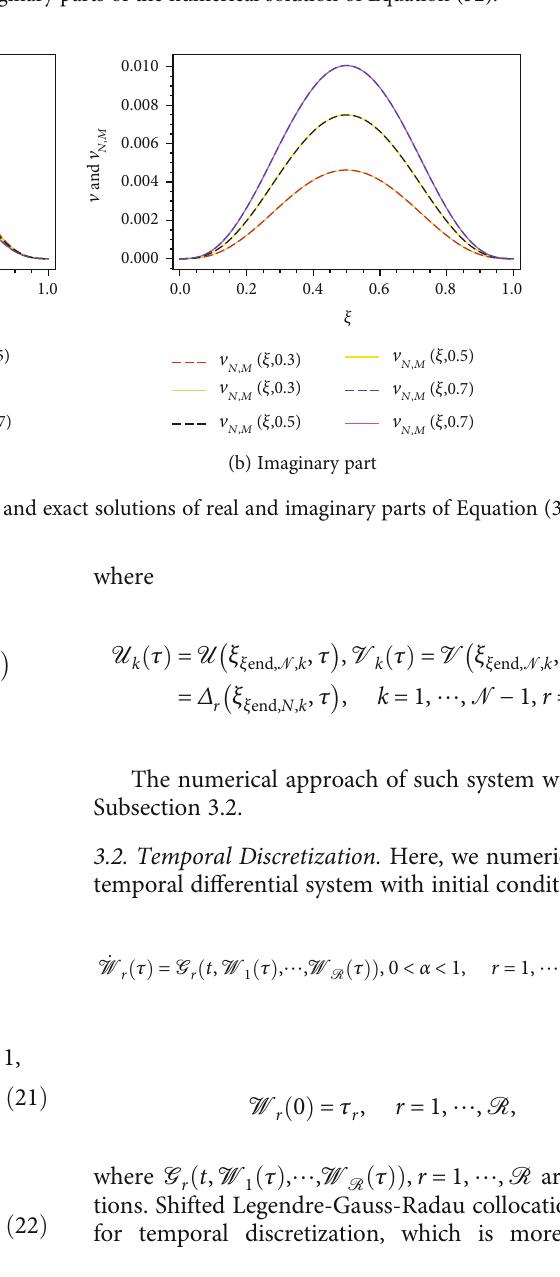
Figure 1: Space graphs of real and imaginary parts of the numerical solution of Equation (32).